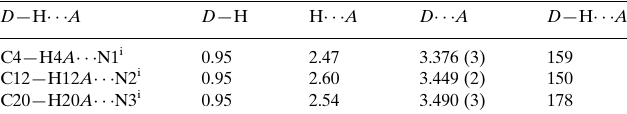
Hydrogen-bond geometry (A˚ , (cid:2)